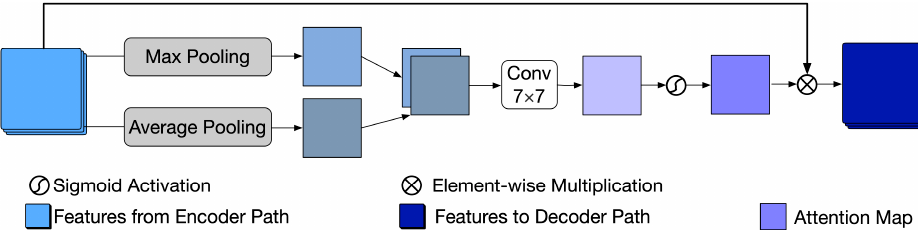
Figure 5. Structure of the proposed spatial attention